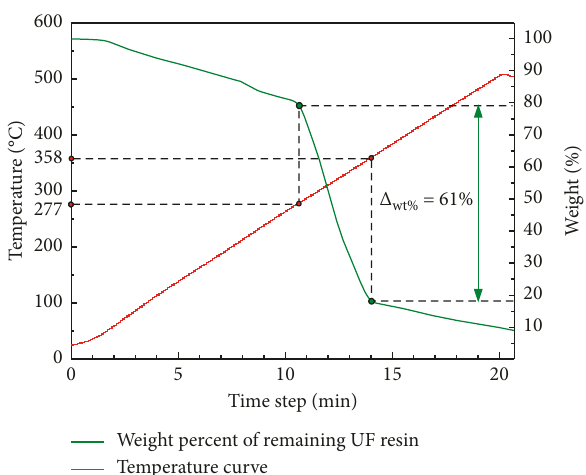
Figure 4: TGA results for the cured UF binder (between room temperature and 560 ° C).